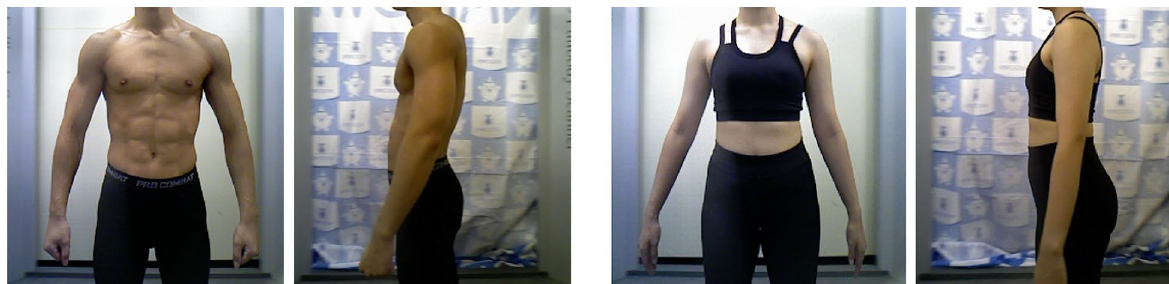
Figure 1. Subjects’ attire and posture.